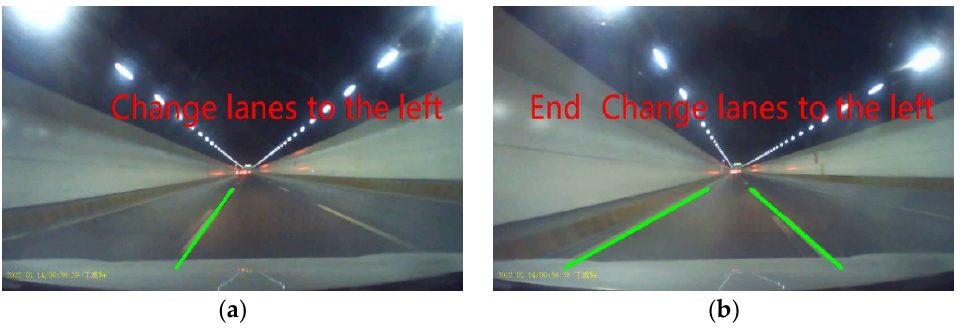
Figure 14. Images of the start and end moments of the vehicle lane change to the left: ( a ) Image of the start moment of the vehicle lane change to the left; ( b ) Image of the end moment of the vehicle lane change to the left.